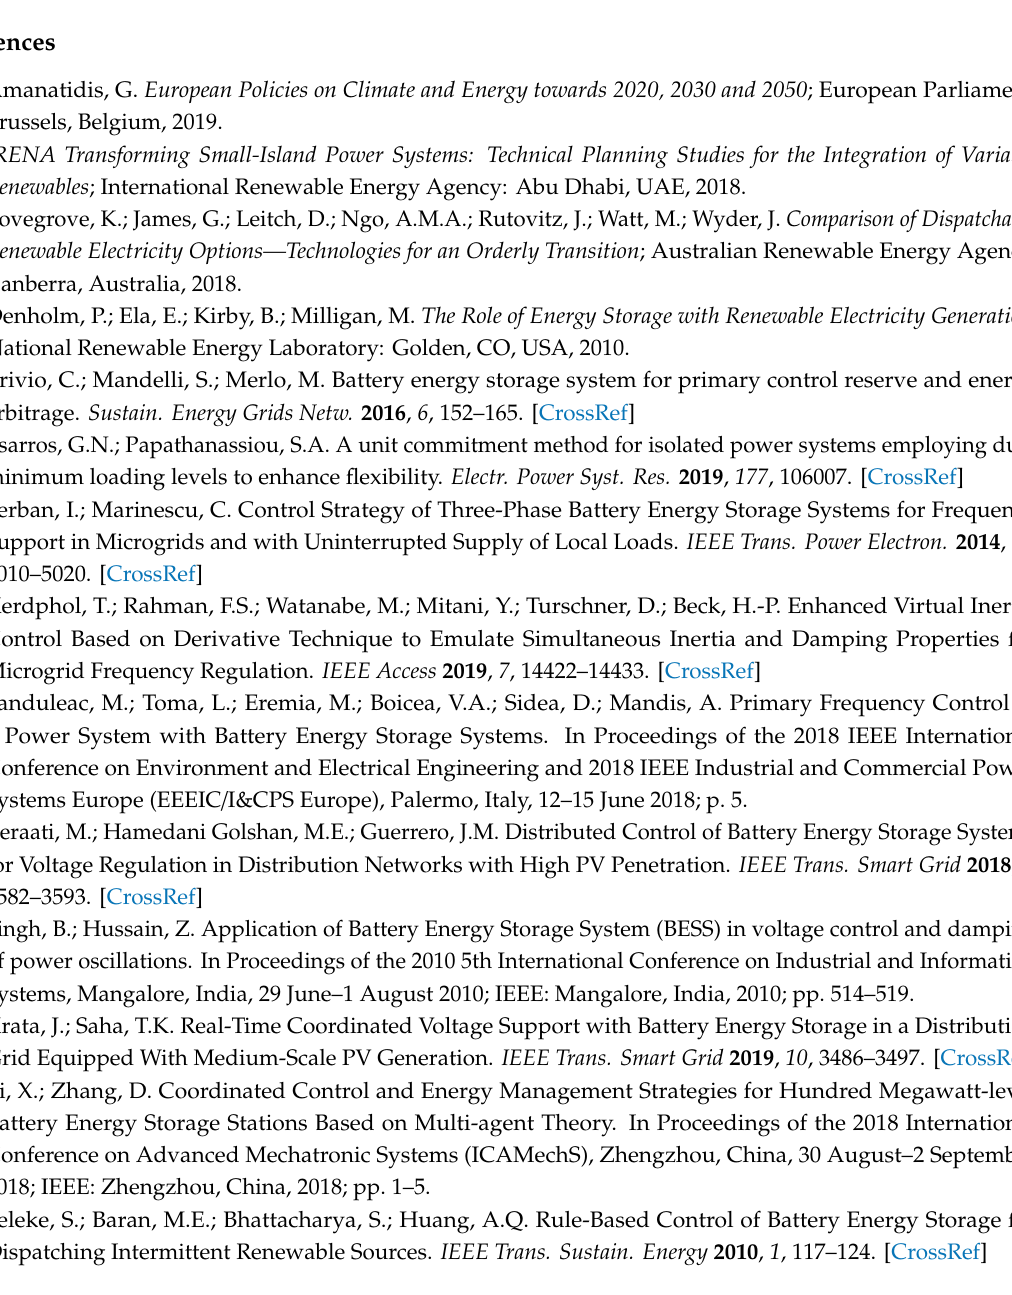
Figure A11. Flywheel energy storage system (FESS) model.